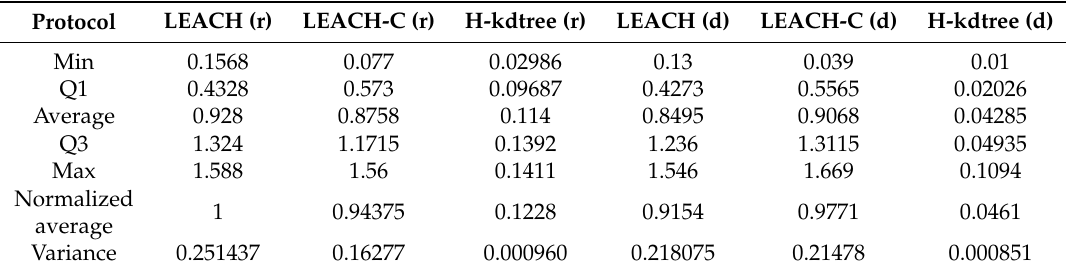
Table 6. Delay with 200 nodes. (r) random—(d)